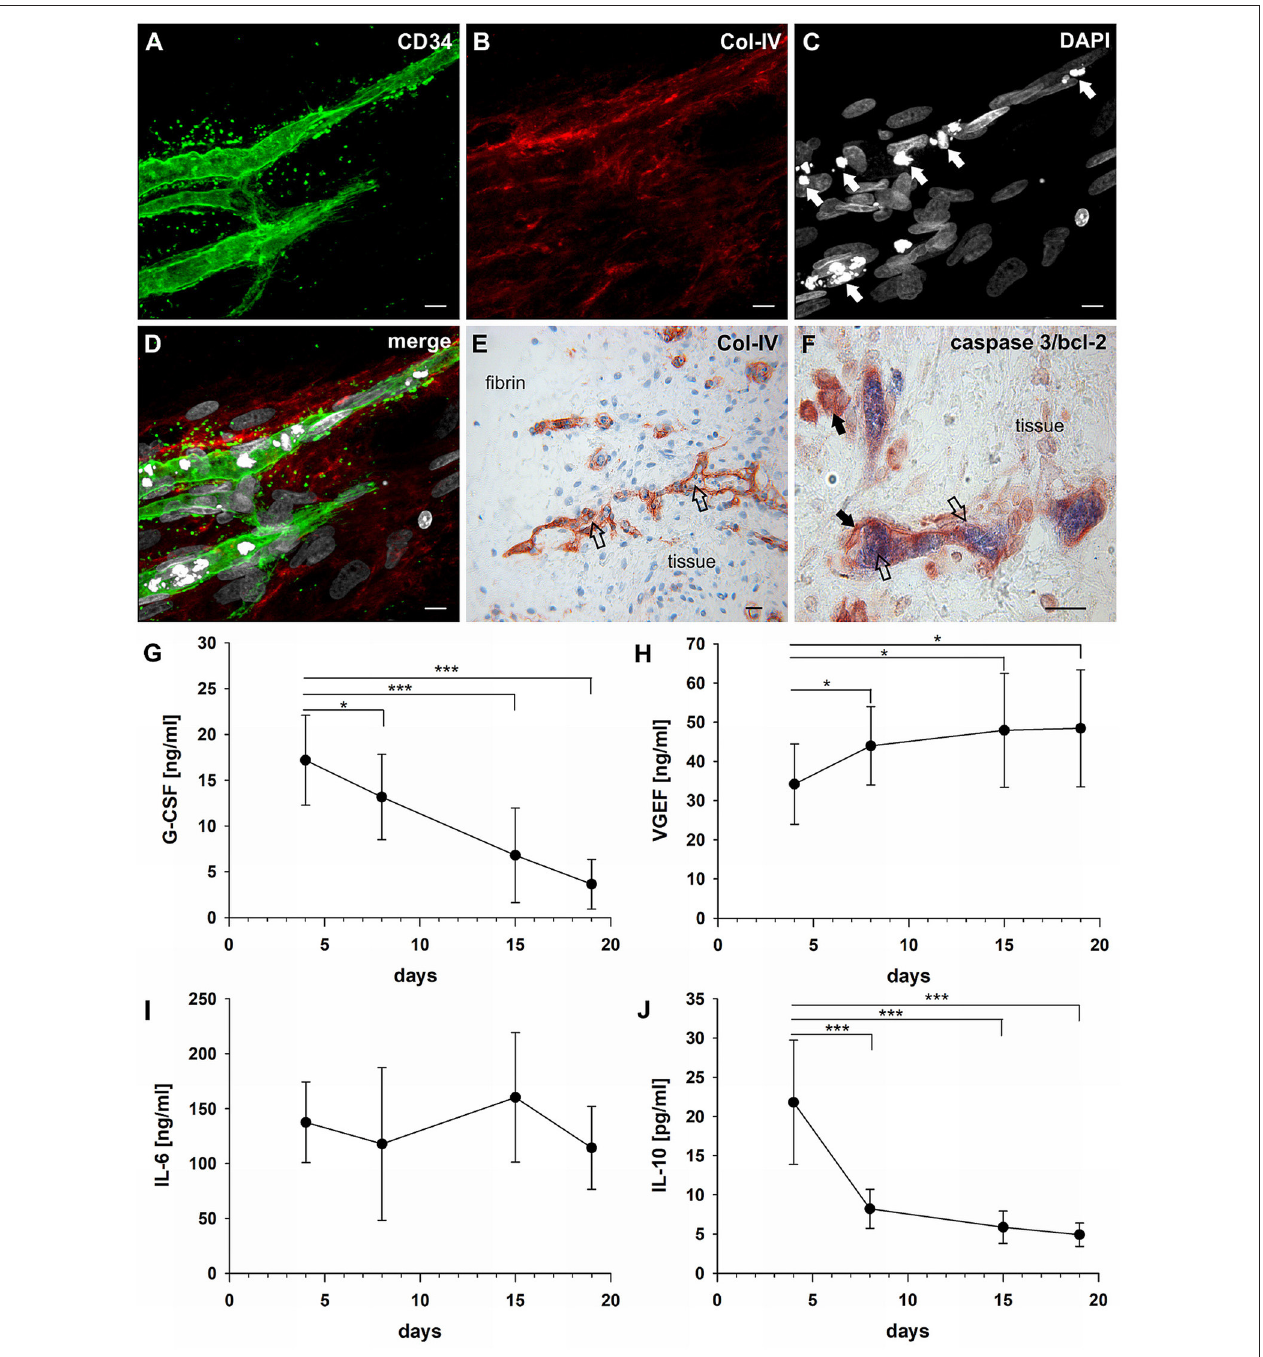
FIGURE 4 | Vascular lumen formation is associated with apoptosis. Immature vascular sprout within the fibrin matrix expressing (A) CD34 and surrounded by (B) Col-IV + stromal/mural cells. (C) DAPI stain showing that the core of the developing vascular sprout contains several cells with condensed nuclei (arrows). (D) Merge. (A–D) CLSM images of intact fibrin gel culture of OA synovial tissue on day 21, collapsed 13 µ m-z-stack consisting of 17 consecutive images. Scale bars, 10 µ m. (E) Neo-vessels of cultured synovial tissue surrounded by Col-IV positive basement membrane and mural cells showing intraluminal cells with condensed nuclei (apoptotic cells) within and outside of the embedded tissue fragment (open arrows). Note the regular nuclear morphology of the extravascular cells within the tissue after extended explant culture. (F) Caspase-3 + intraluminal apoptotic cells (blue, open arrows) within the synovial tissue surrounded by bcl-2 + endothelial cells (arrows). (E) Immunohistochemistry and (F) peroxidase/alkaline phosphatase double-labeling on paraffin sections of RA explant tissue cultured for 28 days. Scale bars, 20 µ m. Kinetics of cytokine secretion during inflammatory neo-vessel development. Determination of (G) G-CSF, (H) VEGF, (I) IL-6, and (J) IL-10 using Bio-Plex 200 system in cell-free explant culture supernatants from three patients with inflammatory OA ( n = 9) taken at days 4, 8, 15, and 19, respectively. Experiments were performed with each sample in duplicate, and data are expressed as mean values ± SD. * p ≤ 0.05, *** p ≤ 0.001.